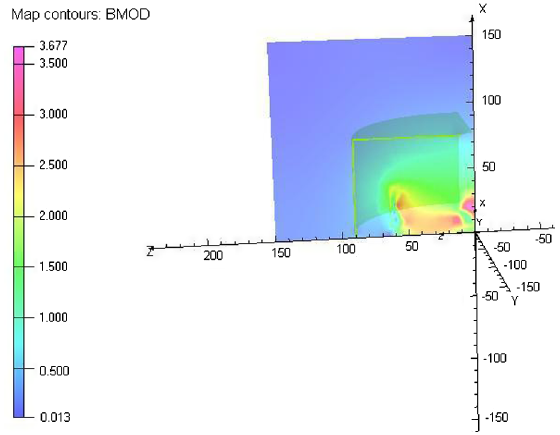
FIG. 17. Intensity distribution of magnetic field induction j B j in the coil and outside the magnetic shield (length in cm and field in